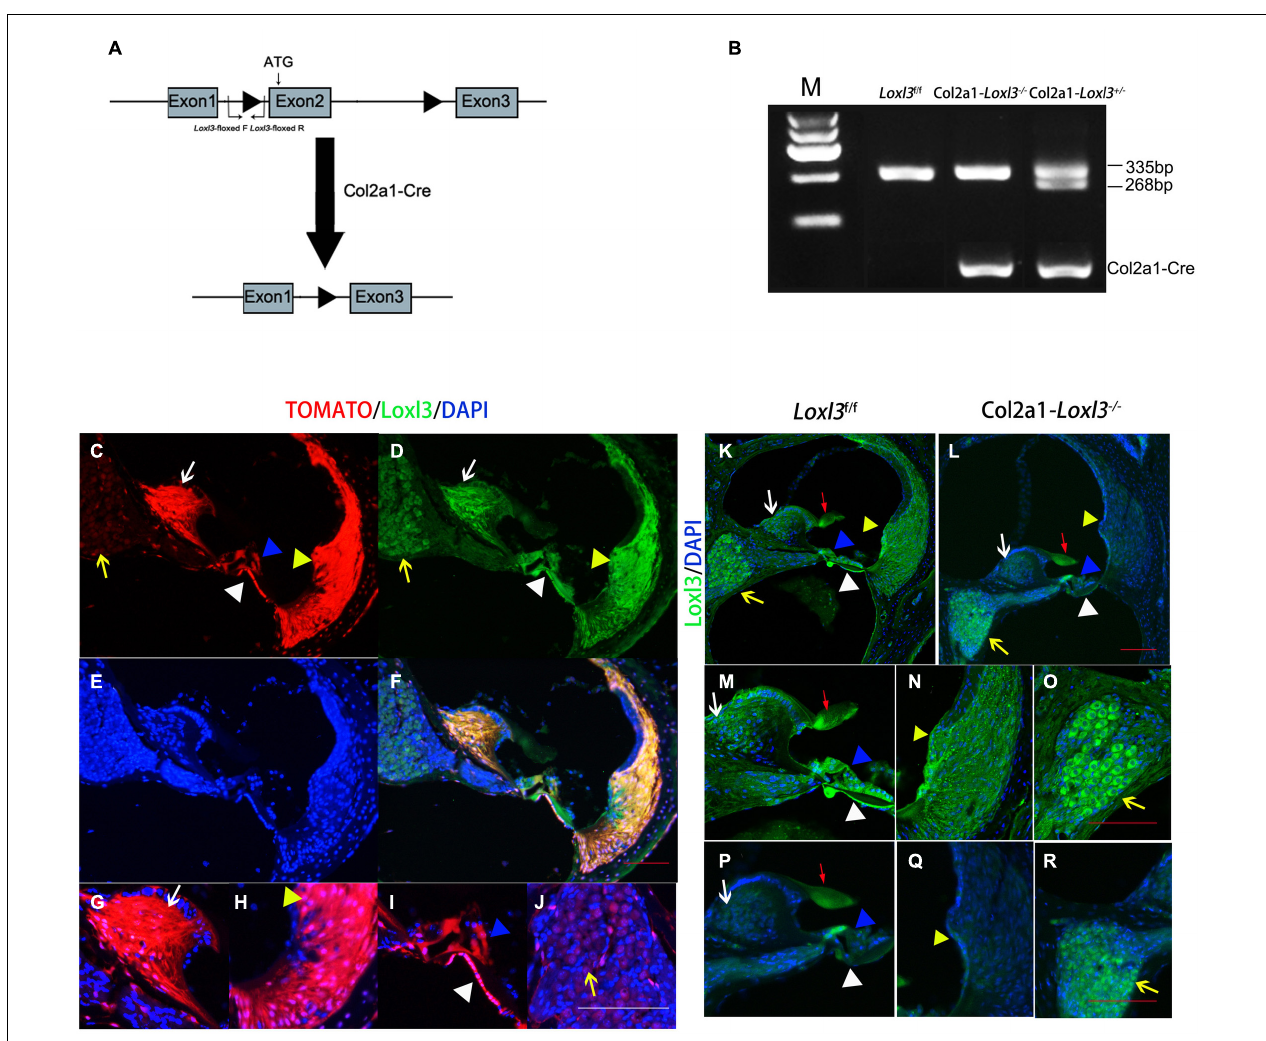
FIGURE 1 | Analysis of Cre recombinase expression in the cochlea of Col2a1-Cre transgenic mice and conditional Loxl3 inactivation in the cochlea of the mice. (A) Schematic diagram of the mice containing floxed Loxl3 alleles crossed with Col2a1-Cre transgenic mice. The deletion of Loxl3 exon 2 leads to deleted ATG start codon for protein translation. (B) Mouse genotyping using PCR analysis. Lane1 wild-type ( Loxl3 f / f ) Lane2 homozygous (Col2a1– Loxl3 − / − ) Lane3 heterozygous (Col2a1– Loxl3 + / − ) mice. (C–F) The Cre recombinase expression under the Col2a1 promoter and expression pattern of Loxl3 in mouse cochlea. The expression of Loxl3 and Cre recombinase was overlapped in the spiral limbus (white arrow), spiral ligament (yellow triangle), basilar membrane (white triangle), and hair cells (blue triangle) The Cre recombinase was expressed sparsely in spiral ganglion cells (yellow arrow). Scale bars: 100 µ m. (G–J) The high magnification of the Cre recombinase expression under the Col2a1 promoter. The expression of Col2a1-Cre recombinase was observed in the most cells of spiral limbus (white arrow), all types of fibrocytes in spiral ligament (yellow triangle), basilar membrane (white triangle), and hair cells (blue triangle). The Cre recombinase was expressed sparsely in spiral ganglion cells (yellow arrow) and not expressed in stria vascularis completely. Scale bars: 100 µ m. (K–L) The targeted inactivation of Loxl3 in Col2a1– Loxl3 − / − mice. The targeted inactivation of Loxl3 was observed in the spiral limbus (white arrow), spiral ligament (yellow triangle), basilar membrane (white triangle), and hair cells (blue triangle), except spiral ganglion cells (yellow arrow) and tectorial membrane (red arrow). Scale bars: 100 µ m. (M–O) The high magnification of the Loxl3 expression. The expression of Loxl3 was observed in the spiral limbus (white arrow), basilar membrane (white triangle), hair cells (blue triangle), tectorial membrane (red arrow), spiral ligament (yellow triangle), and spiral ganglion cells (yellow arrow). (P–R) The high magnification of the targeted inactivation of Loxl3 in Col2a1– Loxl3 − / − mice. The targeted inactivation of Loxl3 was observed in the spiral limbus (white arrow), basilar membrane (white triangle), outer hair cells (blue triangle), and spiral ligament (yellow triangle). Loxl3 was still expressed in tectorial membrane (red arrow), part of inner hair cells and spiral ganglion cells (yellow arrow). Scale bars: 100 µ